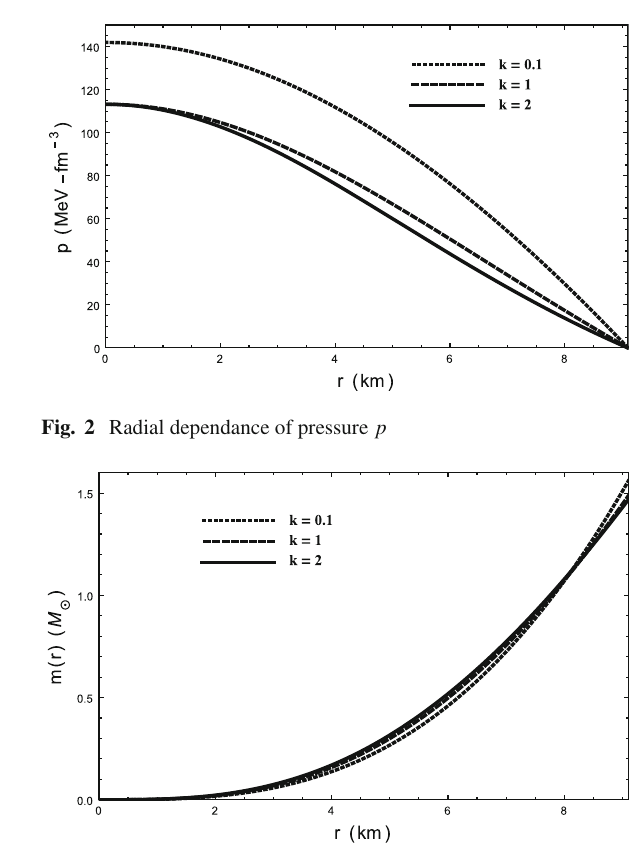
Fig. 3 Radial variation of the mass function m ( r )